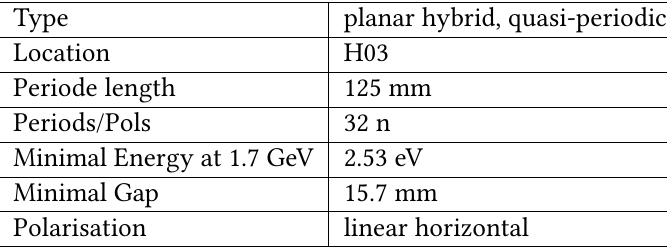
Table 1: Parameters of the undulator